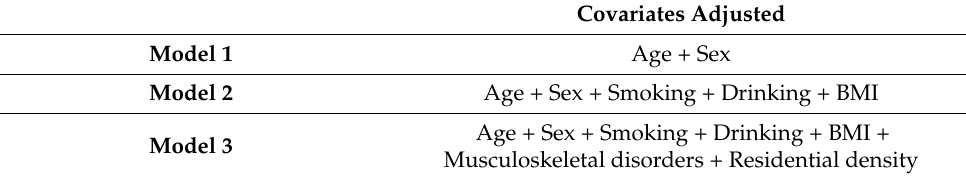
Table 1. Analysis